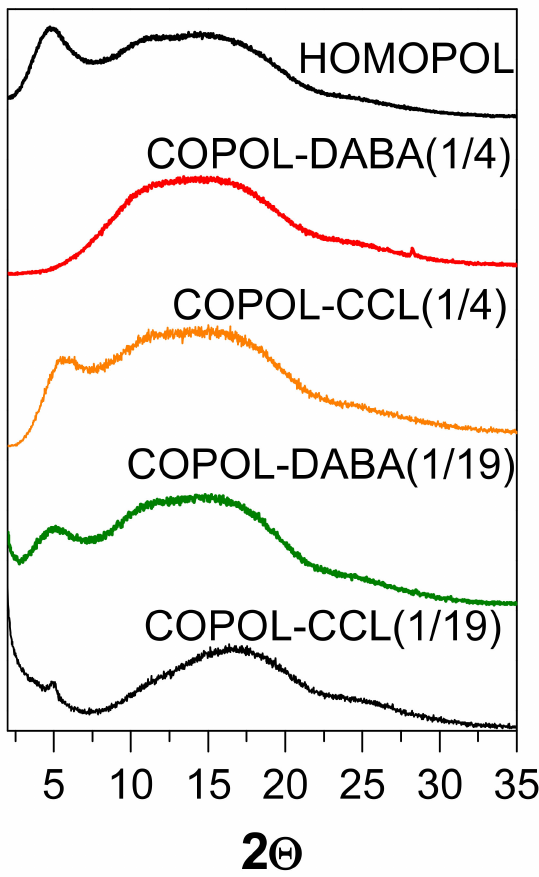
Figure 8. WAXS diffractograms of the homopolymer, DABA-derived copolyimides, and their corre- sponding crosslinked